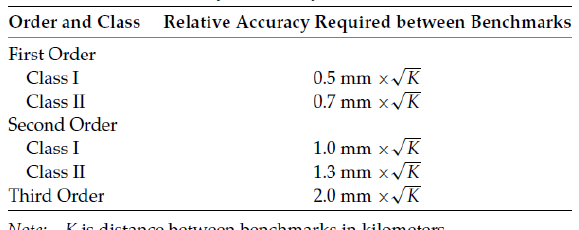
Figure 7. FGCC horizontal control survey accuracy standards of 1984.